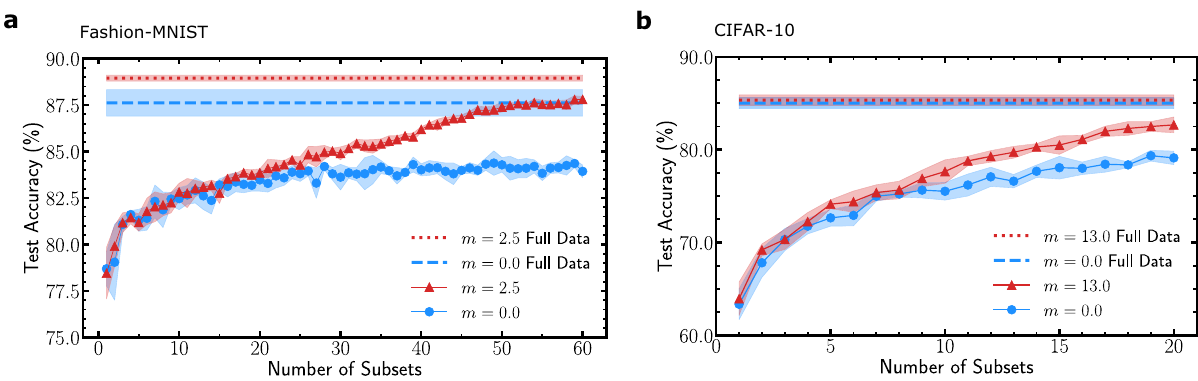
Fig. 5 Stream learning experiments. a Progressive learning of the Fashion-MNIST dataset. The dataset is split into 60 parts consisting of only 1000 examples, and containing all ten classes. Each sub dataset is learned for 20 epochs. The dashed lines represent the accuracies reached when the training is done on the full dataset for 20 epochs so that all curves are obtained with the same number of optimization steps. b Progressive learning of the CIFAR-10 dataset. The dataset is split into 20 parts, consisting of only 2500 examples. Each sub dataset is learned for 200 epochs. The dashed lines represent the accuracies reached when the training is done on the full dataset for 200 epochs. Shadows correspond to one standard deviation around the mean over fi ve